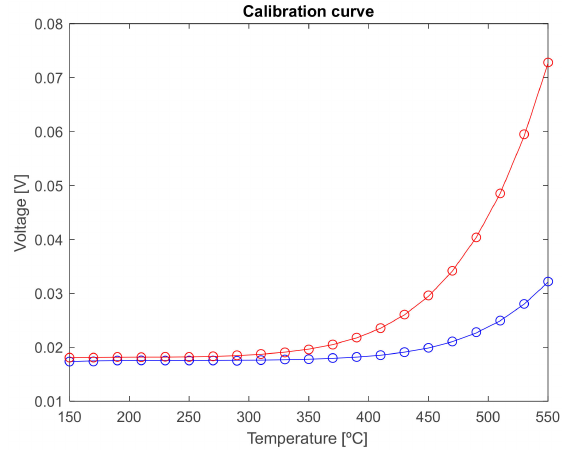
Figure 5. Experimental ( ) and fitting (-) pyrometer calibration curves with the fiber-optic switch: (cid:35) (blue line) 1.31 µ m and (red line) 1.55 µ